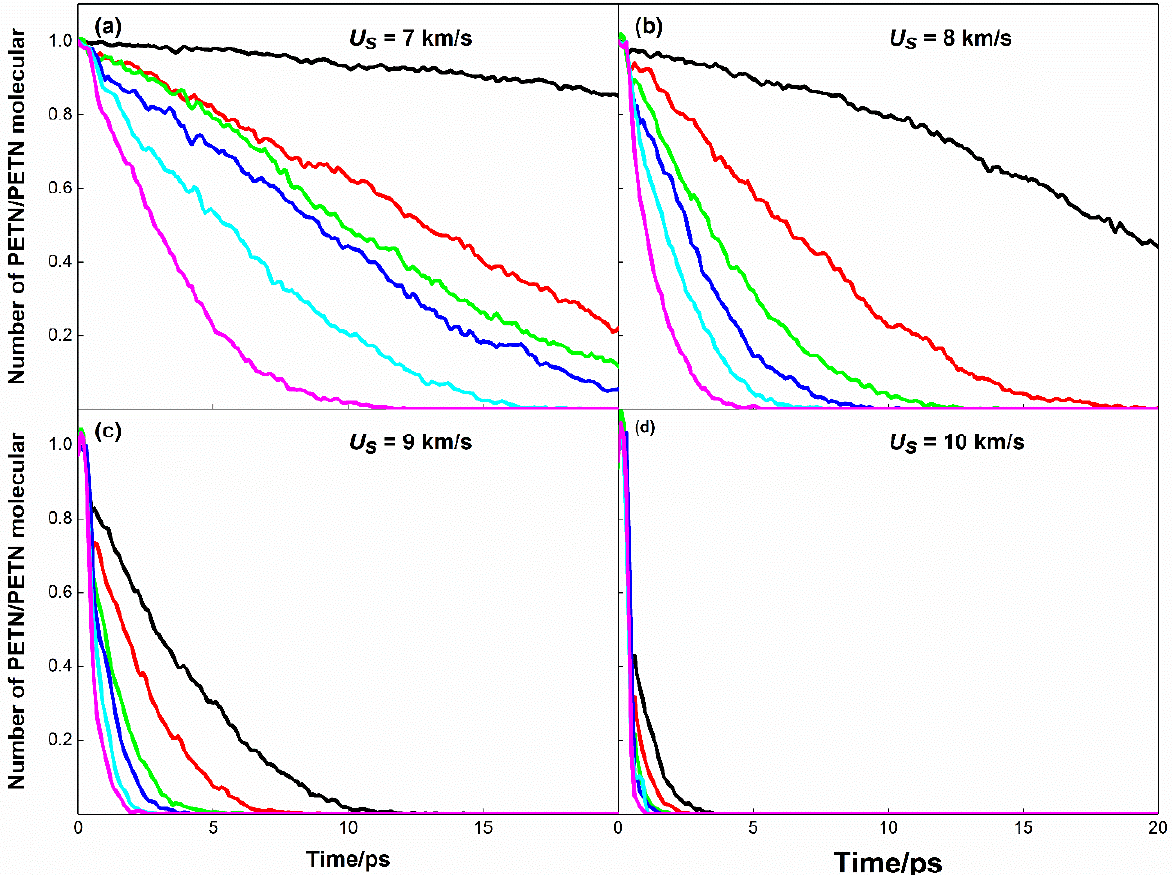
Figure 4. Evolution curves of PETN molecular number during the shock loading. ( a – d ) correspond to shock velocities, Us = 7 km·s − 1 , 8 km·s − 1 , 9 km·s − 1 , 10 km·s − 1 .The vertical coordinates are normalized by dividing by the number of PETN molecules in the initial system. Black, red, and green lines correspond to perfect crystal with preheating temperatures of 300 K, 500 K, and 700 K. Blue, cyan, and magenta line correspond to Defect crystal with preheating temperatures of 300 K, 500 K, and 700 K.